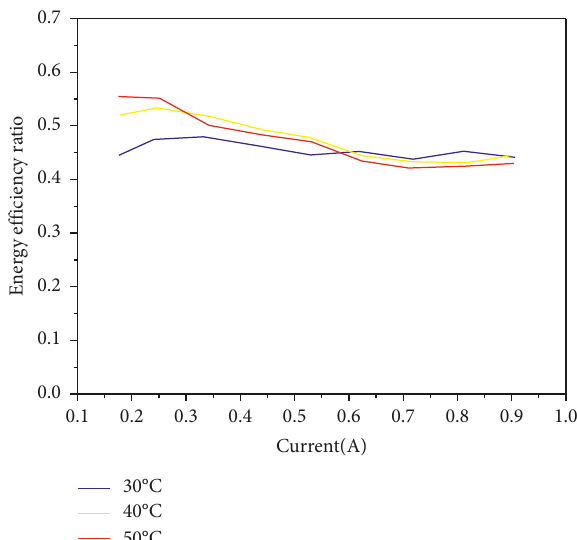
Figure 10: Variation of energy efficiency ratio of electrolytic water with temperature under the working condition of 0.5% dilute sulfuric